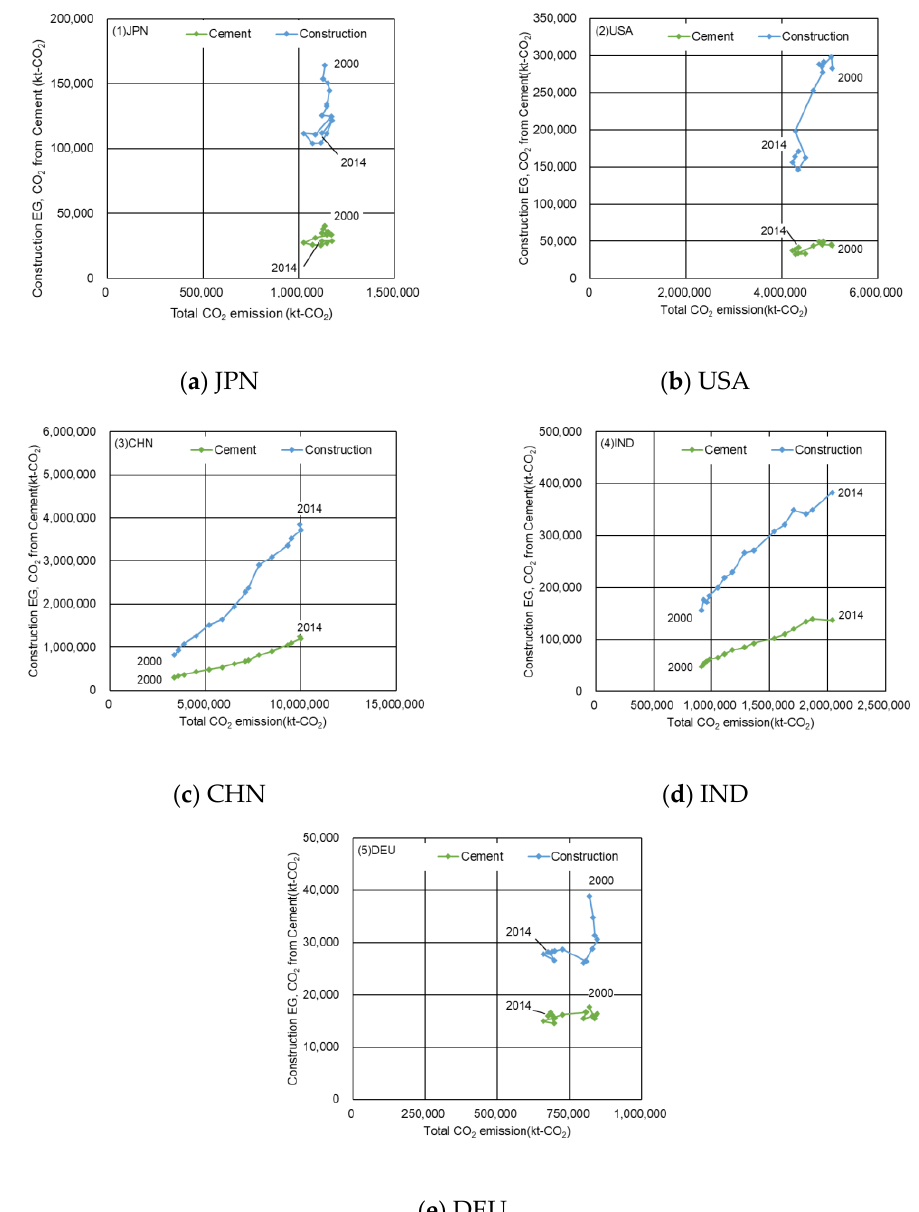
Figure 9. Annual variations in total CO 2 emissions, construction EGs, and CO 2 emissions from cement production.